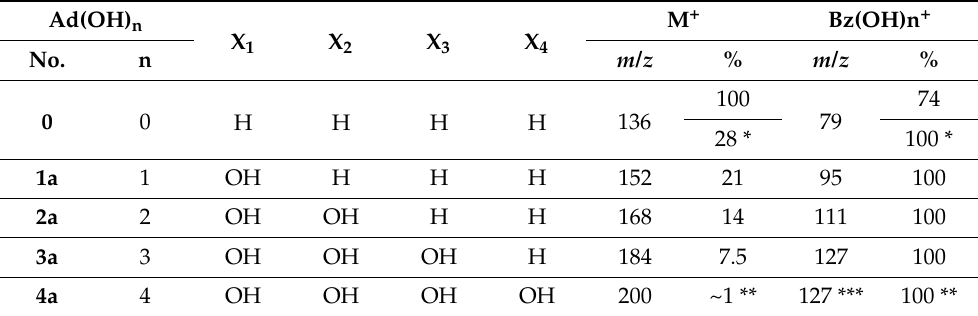
Table 4. Relative intensities of peaks of molecular and main fragmentation ions in electron ionization